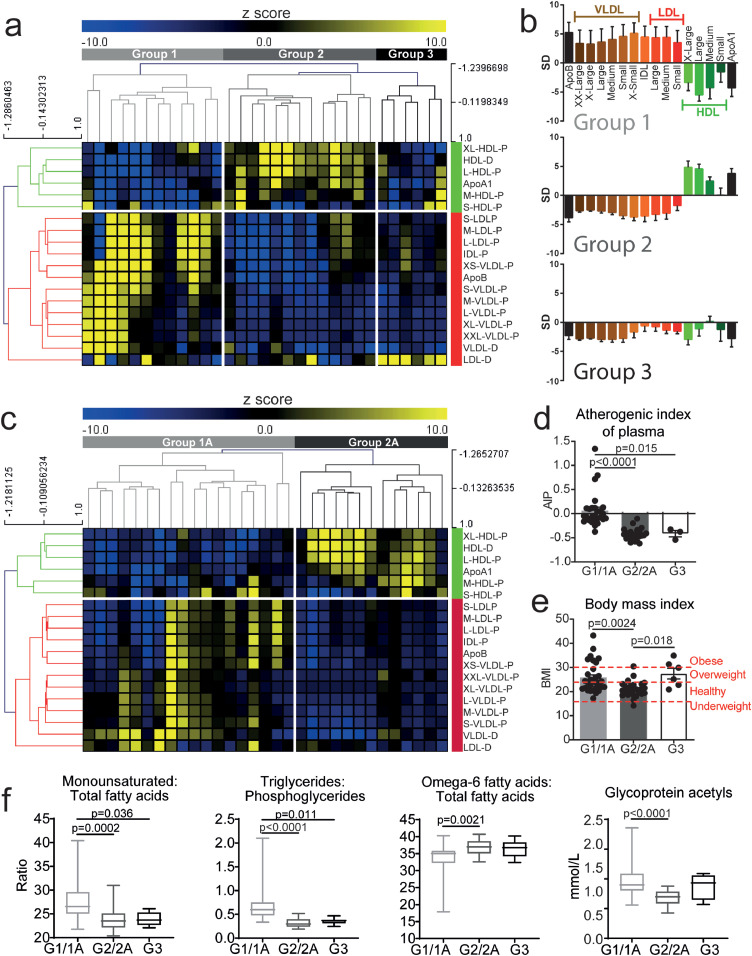
JSLE patient stratification by lipoprotein profile reveals unique and validated patient groups. Metabolomic analysis was performed on serum from a discovery cohort (n=31, a-b) and validation cohort (n=31, c). (a) Heat map showing unbiased hierarchical clustering of lipoprotein particle (P) concentrations and diameters (D) and apolipoproteins (Apo), z-score converted measurements. Groups are labelled; Group-1=light grey, Group-2=dark grey, Group-3=black. Anti- and pro- atherogenic lipoproteins clustered (labelled in green and red respectively). (b) Lipoprotein subclasses measurements from Group-1-3 (from A). Standard deviation (SD) units showing deviation from the mean value of the whole study population. Error bars indicate standard error. (c) Heat map showing unbiased hierarchical clustering of lipoproteins and apolipoproteins using z-score converted measurements. Two groups identified: Group-1A=light grey and Group-2A=dark grey. Anti- and pro- atherogenic lipoproteins clustered (labelled in green and red respectively). (d-e) Discovery and validation JSLE cohort data were combined (Group-1/1A (n=30), Group-2/2A (n=26)) and discovery cohort Group-3 (n=6). (d) Atherogenic index of plasma [Log(Triglycerides/HDL-Cholesterol)] and (e) Body Mass Index (BMI) of patients. Dashed red lines indicate the cut off BMI values for underweight, healthy, overweight and obese. (f) Levels of four metabolites identified previously in SLE patients with pre-clinical plaque [35] in Group-1/1A (n=30), Group-2/2A (n=26)) and discovery cohort Group-3 (n=6). One-way ANOVA. Abbreviations: Apo, apolipoprotein; VLDL, IDL, LDL, HDL, very low, intermediate, low and high-density lipoproteins; XX-large, chylomicrons and extremely large; X-Large, very large; X-small, very small.